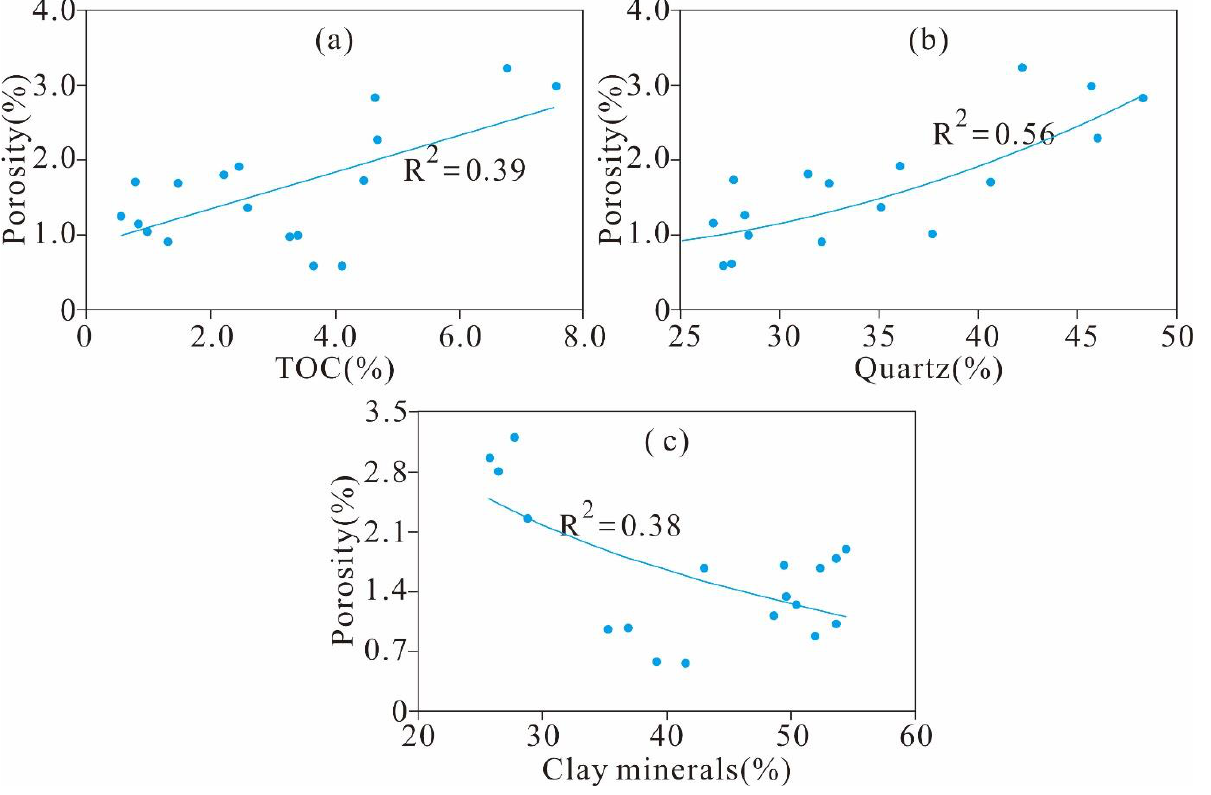
Figure 9. Relationships between the porosity and TOC content ( a ), quartz ( b ) and clay ( c ).